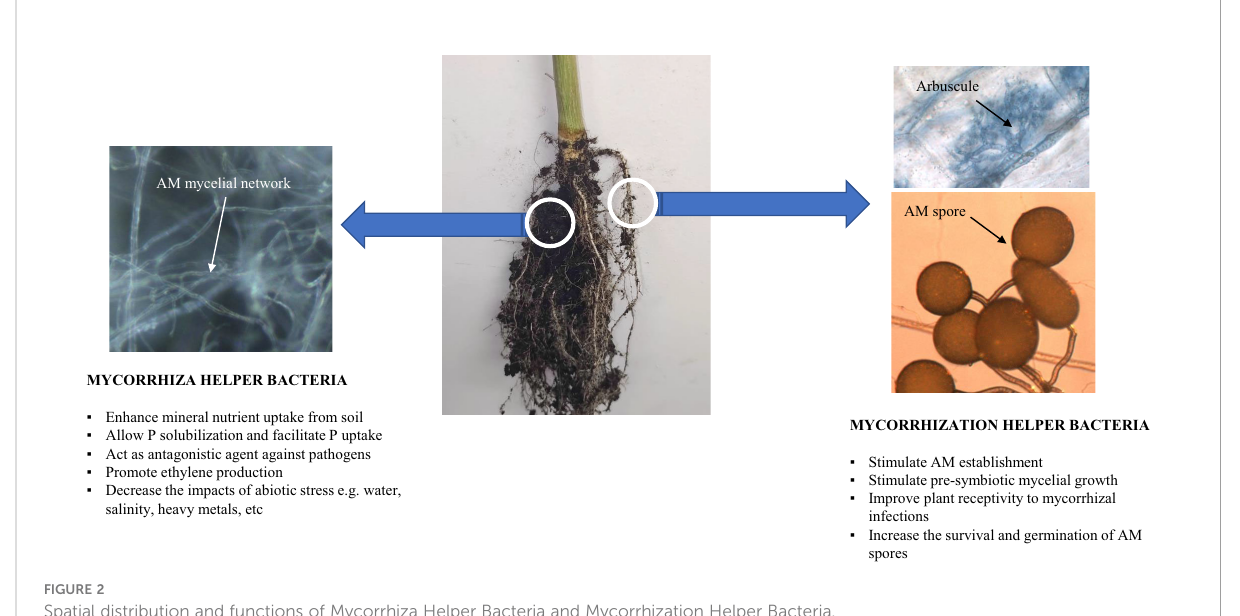
FIGURE 2 Spatial distribution and functions of Mycorrhiza Helper Bacteria and Mycorrhization Helper